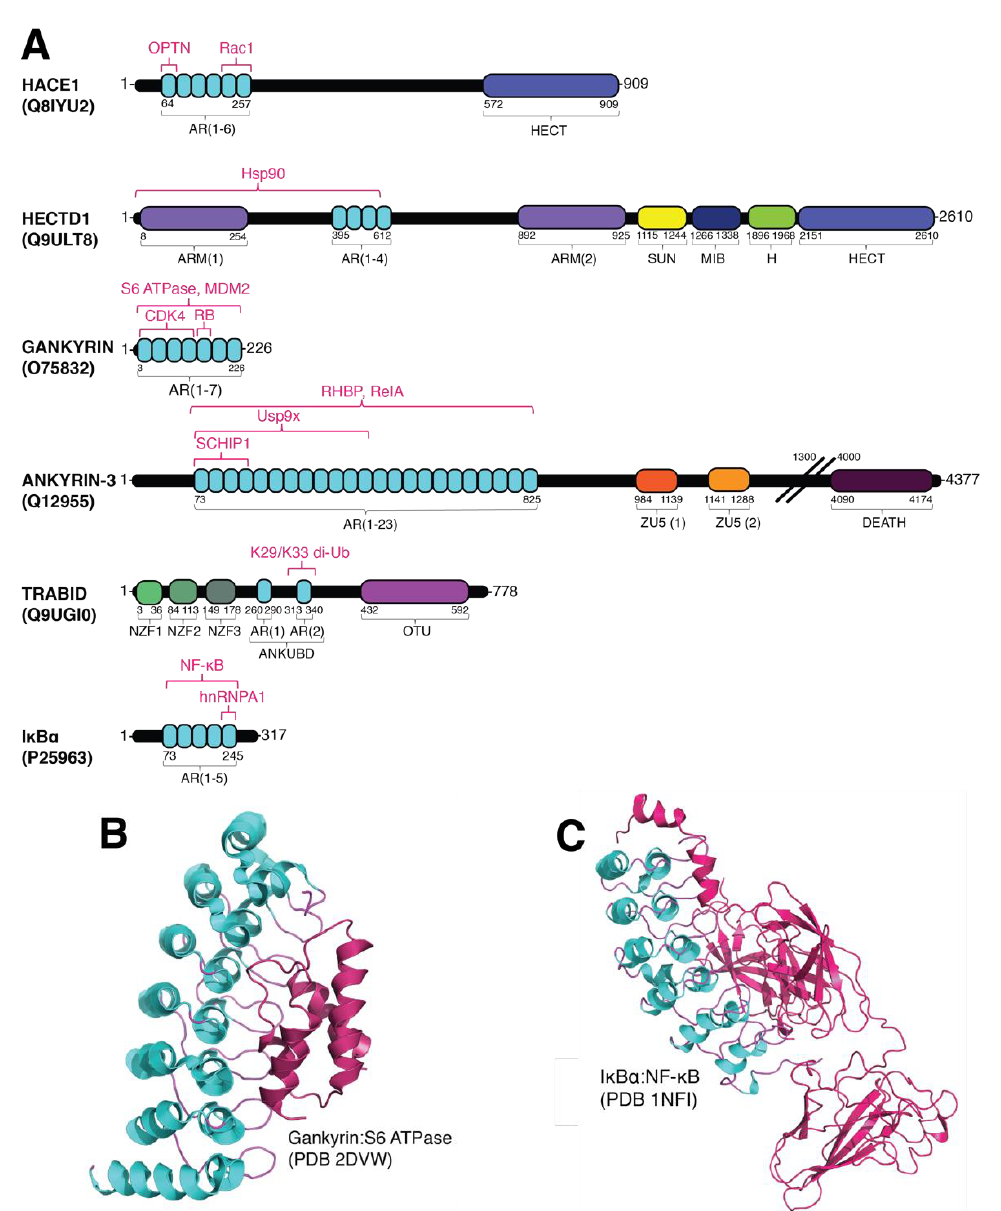
Figure 3. Domain architecture of AR domain-containing proteins and AR domain-complex formation. ( A ) Putative domain architecture of AR-containing proteins discussed in this review. While each protein has a variety of domains that facilitate protein–protein interactions, the AR domains are highlighted for their role in mediating the ubiquitylation signaling pathway. Domain abbreviations used include: AR, ankyrin repeat; HECT, homologous to E6AP C -terminus; ARM, armadillo repeat-containing domain; SUN, SAD1/UNC domain; MIB, mind-bomb domain; H, helical bundle; ZU5, ZU5 domain; DEATH, death domain; NZF, Npl4 zinc finger domain; OUT, ovarian tumor domain. Identified substrates and sites of interaction are highlighted in magenta. Substrate abbreviations used included: OPTN, optineurin [30]; Rac1, Ras-related C3 botulinum toxin substrate 1 [31]; Hsp90, heat shock protein 90 [32]; MDM2, mouse double minute 2 homolog [33]; CDK4, cyclin-dependent kinase 4 [34]; RB, retinoblastoma protein [35]; RHBP, rhodnius heme-binding protein [36]; RelA, transcription factor p65 [37]; Usp9x, ubiquitin specific peptidase 9 X-Linked [38]; proteosomal subunit